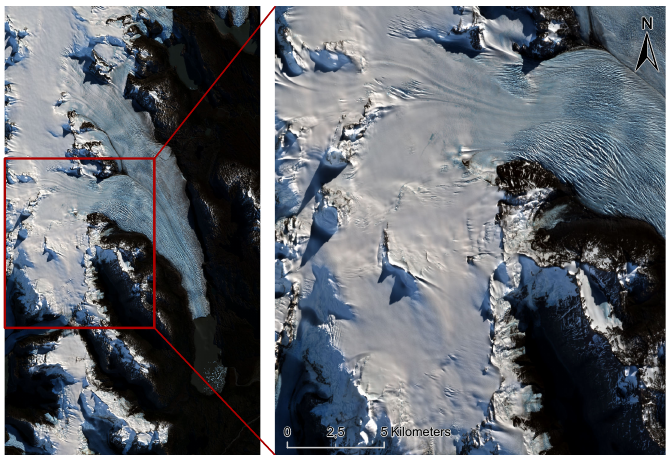
Figure 4. Subsets considered in the scope of this paper: subset S comprising a smaller part of the upper glacier area ( right ), and subset S Tyndall comprising the whole glacier area ( left ). Since the area surrounding the glacier is not of particular interest, a corresponding image mask created via manual annotation is applied. Furthermore, a masking of shadow areas is performed (cf. Section 2.3.2).